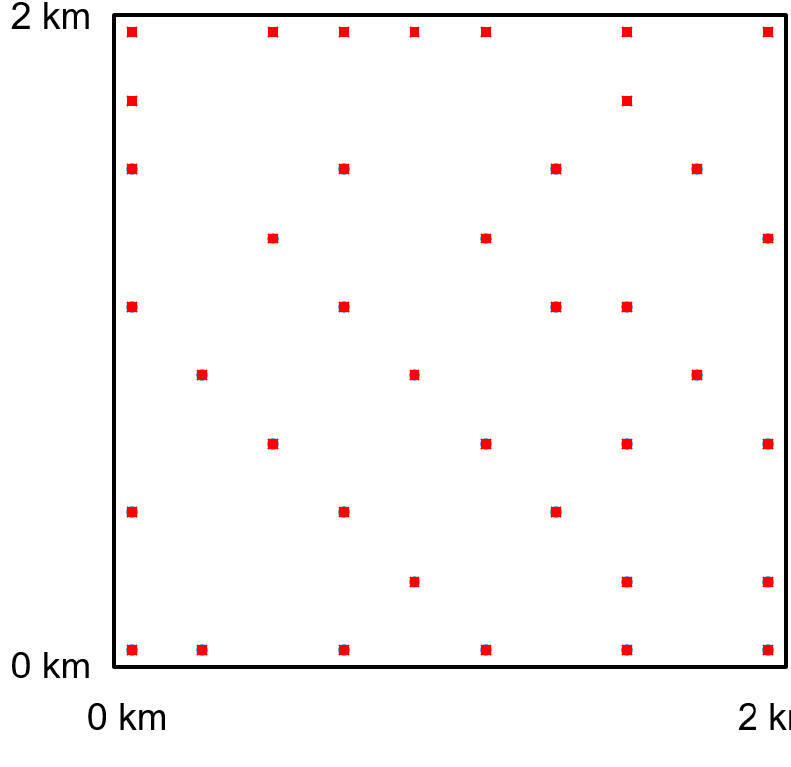
Figure 4. Optimal layout from Grady et al. [60]. Table 1. Wind farm